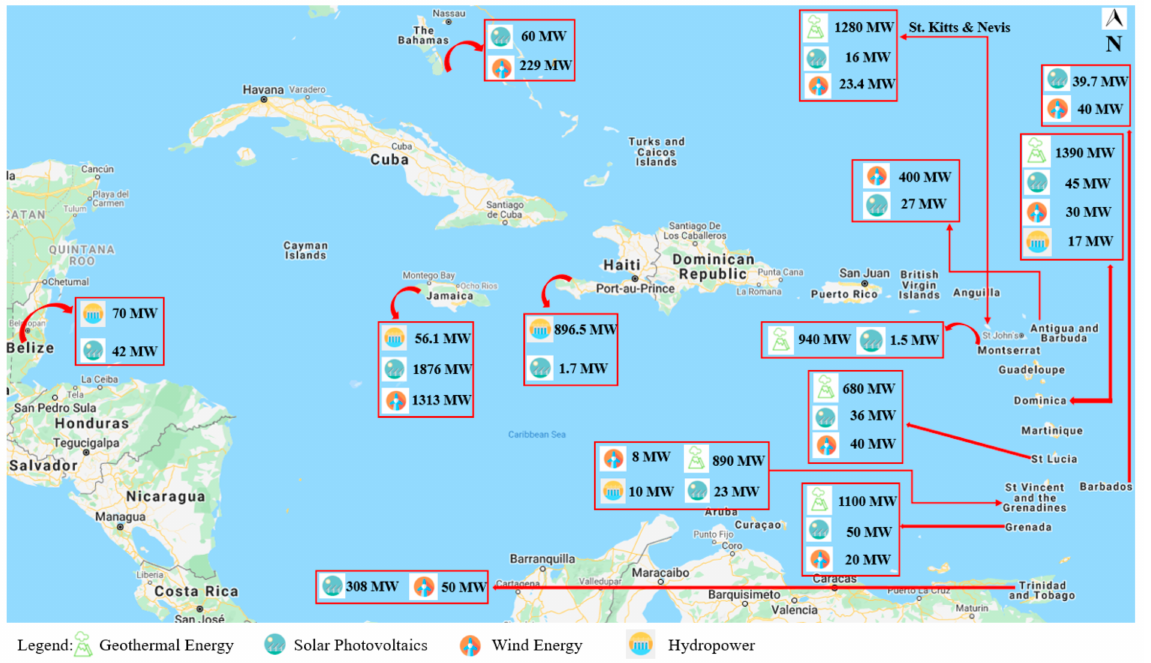
Figure 1. Renewable energy distribution across the Caribbean Community (CARICOM) nations. Map created based on data from Ochs et al.